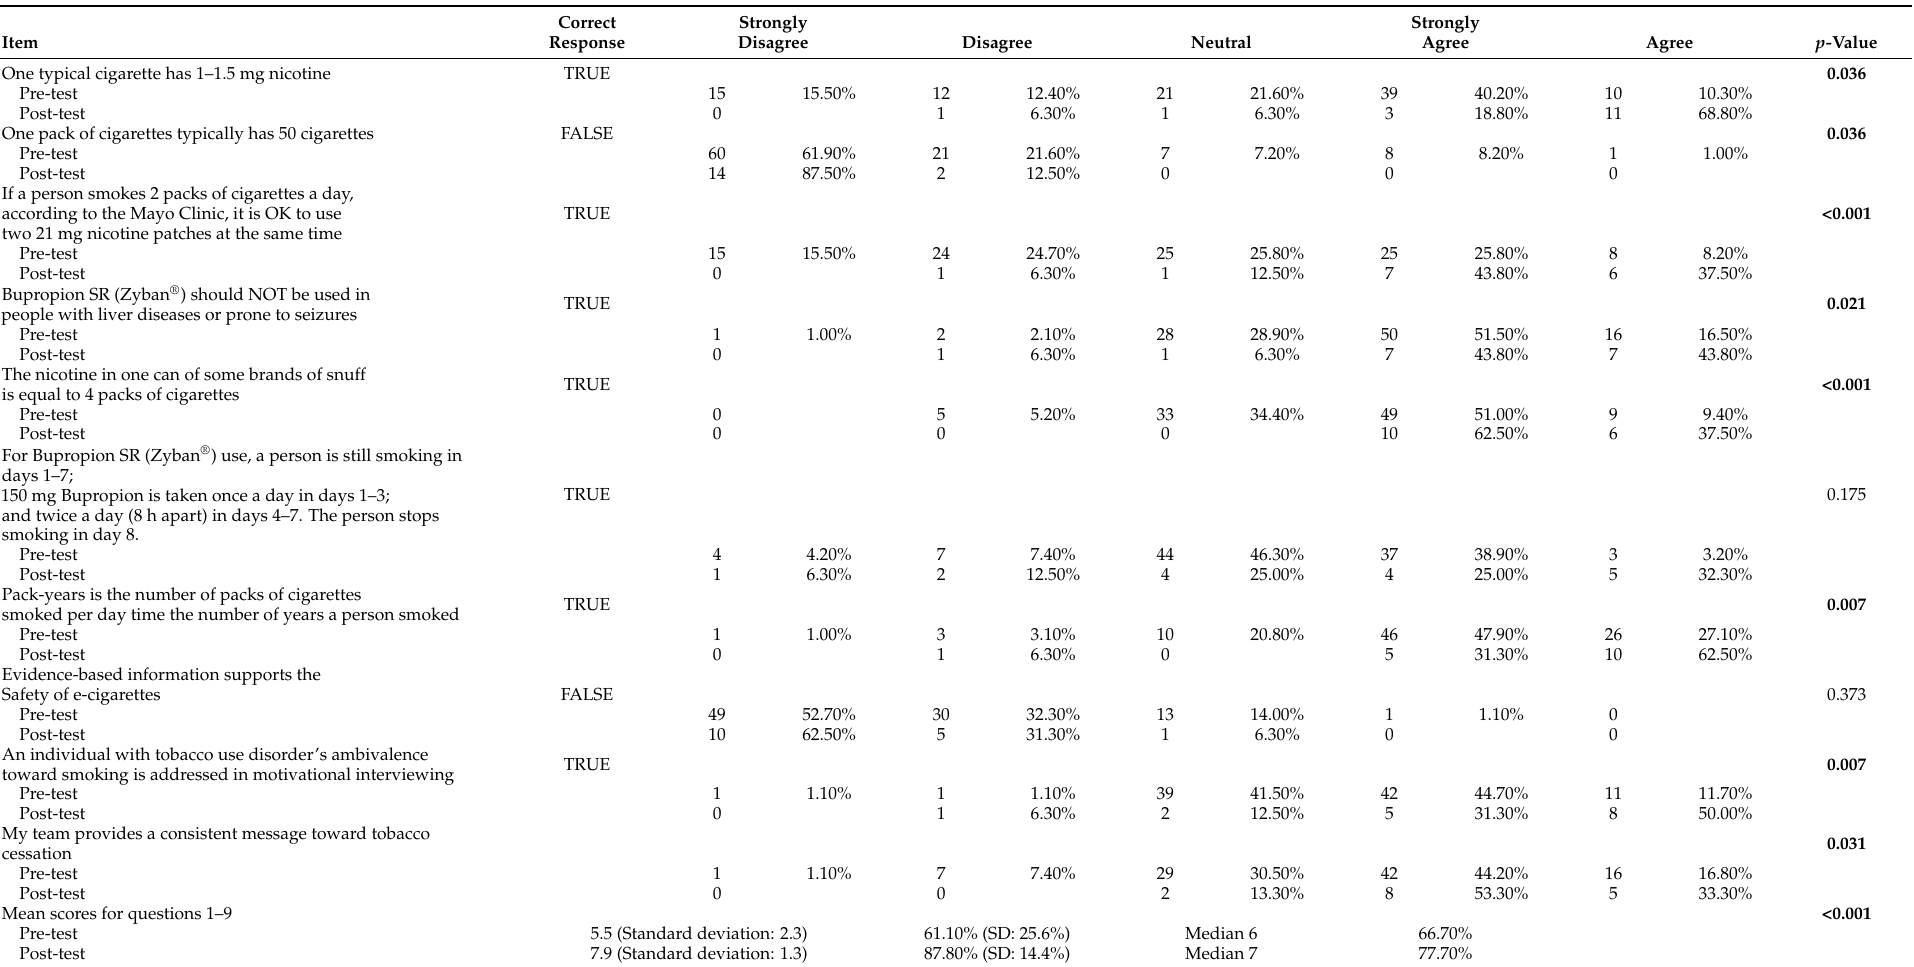
Table 1. Learning/Knowledge Gained between the Pre-test and